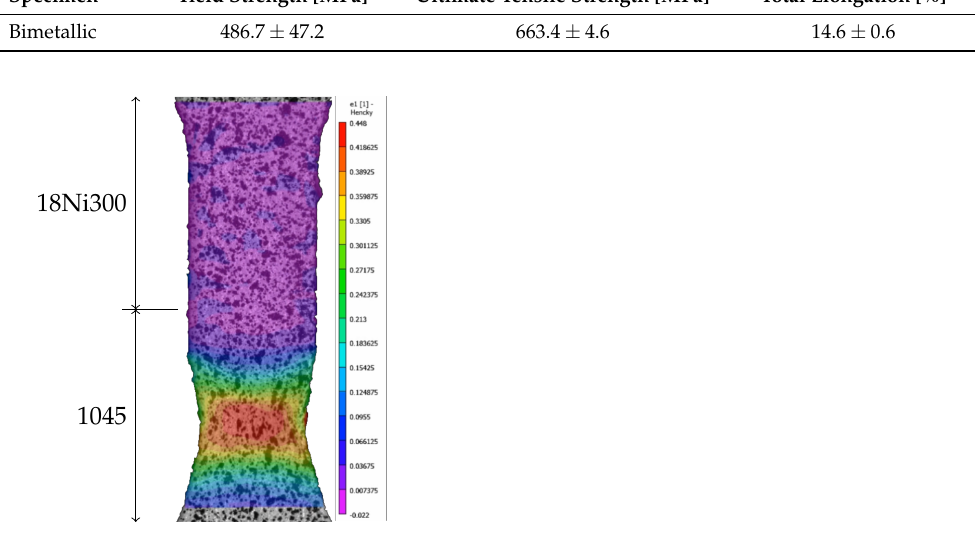
Figure 8. DIC-computed strain field along the loading direction of the bimetallic